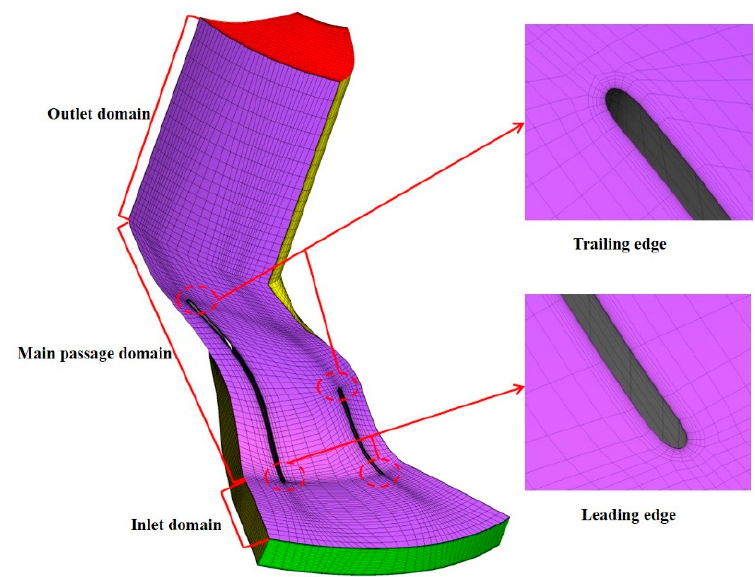
Figure 6. The grid of impeller passage. Table 5. Thermodynamic properties of